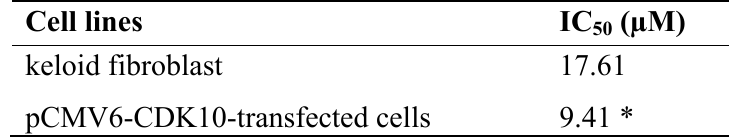
) values for tamoxifen towards keloid 50